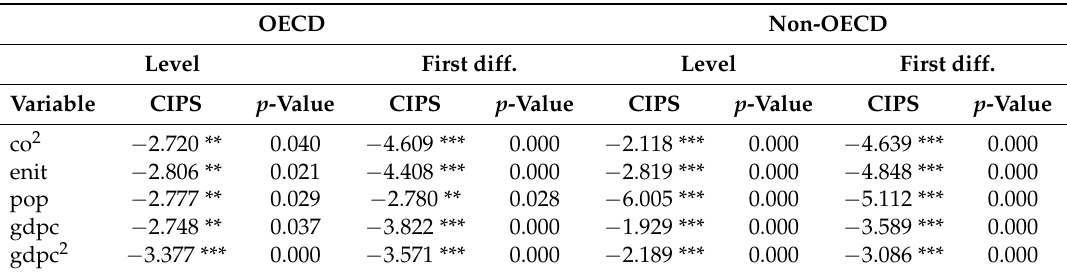
Note: *** and ** statistical significance at the 1% and 5%